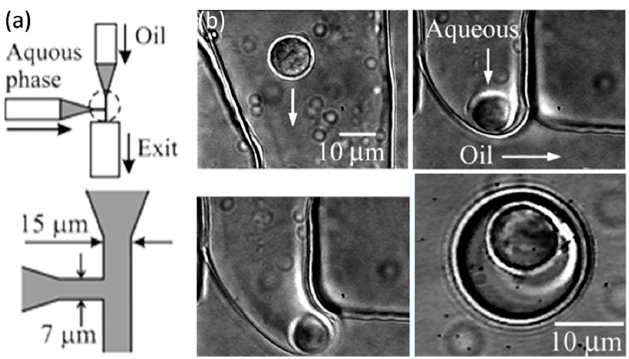
Figure 1. ( a ) Schematic of a microfluidic T channel and ( b ) sequences of images showing the encapsulation of a single B lymphocyte into an aqueous droplet in silicone oil. Optical trapping was used to transport and position the cell close to the water/oil interface. Upon application of a pressure pulse to the microchannels, the cell was carried away by the flow as the droplet was sheared off. Reproduction with permission from